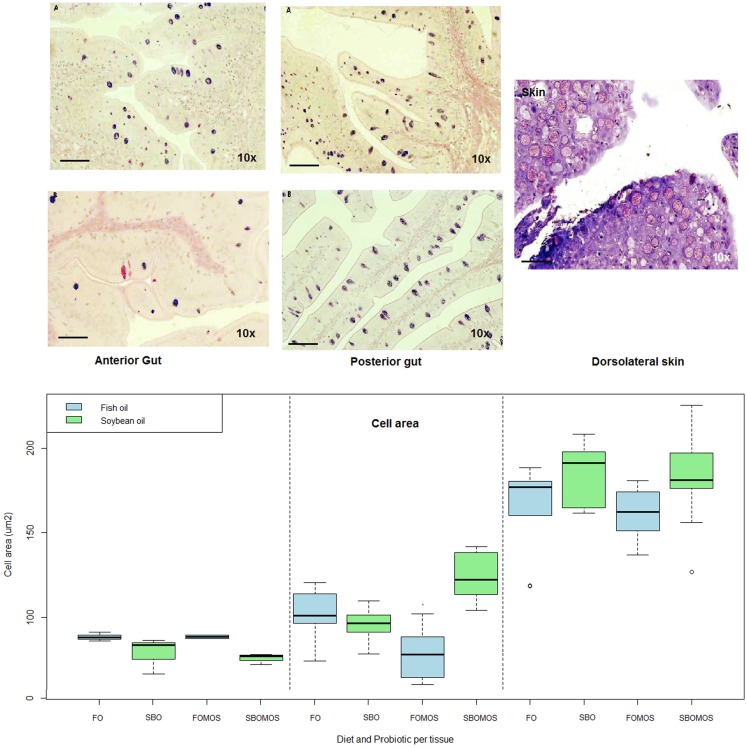
Top left: Histological sections of anterior gut (left) and posterior gut (center) fed with (A) FO- and (B) SBO-based diets, stained in Alcian Blue-PAS. Top right: histological section of skin fed with fish oil and stained with Toluidine Blue (scale bar = 300 μm). Bottom: Mucous cell area (μm2) depending on tissue and diet. From left to right: anterior gut, posterior gut, and skin, differentiated significantly by a dotted line (P = 2e–16, F-test). Green color is soybean oil and blue color is fish oil. N = 36 fishes.